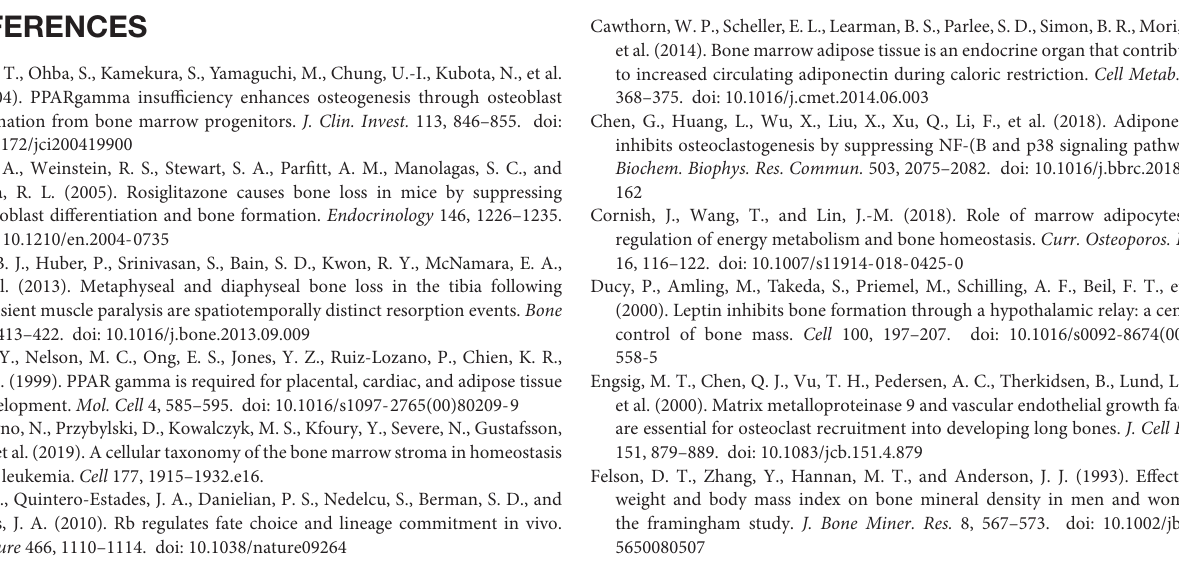
Supplementary Figure 1 | Osteoblastic activity is increased in mice with epiblastic deletion of PPAR g . (A) Representative 3-D micro-CT of the fourth lumbar vertebrae of CTL and Pparg (cid:49)/(cid:49) ( γ (cid:49)/(cid:49) ) mice. n = 5 WT and 5 γ (cid:49)/(cid:49) . (B) Trabecular bone volume fraction measured by micro-CT analysis of vertebra from γ (cid:49)/(cid:49) ( n = 5) and control (CTL; n = 5) littermates. (C) Trabecular connectivity density measured by micro-CT analysis of vertebra from γ (cid:49)/(cid:49) ( n = 5) and control (CTL; n = 5) littermates. (D) Keratocan and Sost mRNA levels in long bones of CTL ( n = 6) and γ (cid:49)/(cid:49) ( n = 6) mice. Supplementary Figure 2 | Parathyroid hormone (PTH) signaling. The serum levels of PTH were assessed by Elisa Assay in 1-year-old male and female mice ( Pparg (cid:49)/(cid:49) , AZIP tg / + , and their control littermates). Six males and six females were included per genotype. As there were no statistically significant differences between males and females, the analysis was performed using the total number of mice (mean ± SD ). Lower panels: mRNA expression levels of Pth1r in the bones and in the kidneys of CTL vs. Pparg (cid:49)/(cid:49) mice. Supplementary Figure 3 | Adiponectin expression levels in long bone and in adipocyte-conditioned medium. RT-qPCR analysis of Leptin and AdipoQ mRNA levels in long bone from A-ZIP tg / + ( n = 8) and their CTL littermates ( n = 8) and from γ (cid:49)/(cid:49) ( n = 7) and their CTL littermates ( n = 6). Data are presented as mean ± S.E.M. Statistical significance was determined by two-tailed unpaired t -test. Supplementary Figure 4 | AdipoRon inhibits osteoclast (OCL) differentiation of various origins. Left panels: representative images of TRAcP stained (A) BM-derived, (B) spleen derived, and (C) macrophages enriched fraction osteoclasts differentiated in the presence or absence of AdipoRon (5 µ M). Right panels : the mean IC50 of AdipoRon inhibition of OCL differentiation was determined from the curve with the error of the fit (S.E.M.) Data are mean ± S.E.M. ( n = 3 biological replicates). Supplementary Figure 5 | AdipoRon inhibits human osteoclast (OCL) differentiation and activity through AMPK activation. (A) Dose response effect of AdipoRon on osteoclast differentiation from hPBMC ( n = 5). (B) Representative images of TRAcP staining of hPBMC derived osteoclast differentiation in the presence or absence of AdipoRon (5( µ M). (C) Western-blot analysis of hPBMC-derived osteoclasts treated with AdipoRon (5( µ M). AdipoRon treatment activates AMPK phosphorylation (p-AMPK) in hPBMC after 5 min. (D) Fluorescence microscopy of phalloidin-marked podosomes in hPBMC derived OCL in the presence of AdipoRon (5 µ M, 12 h) (representative images of n = 5). Supplementary Table 1 | Primers used for